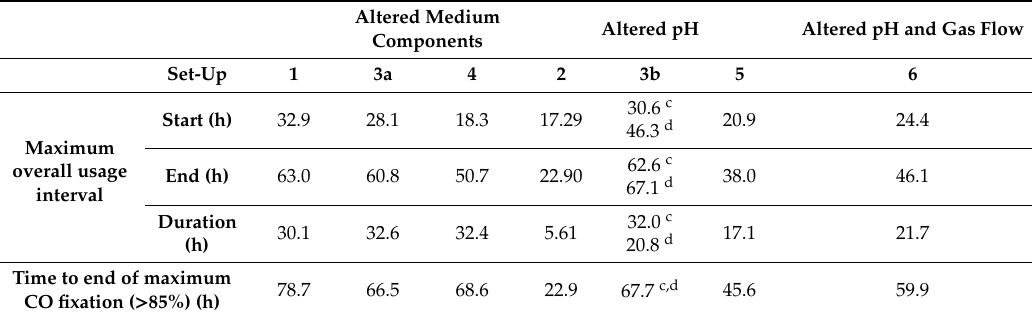
Table 2. Gas consumption profiles. All values given as an average of a triplicate ( n = 3), except for the following: Setup 3a refers to values of the fermenter where pH was not altered and Setup 3b refers to the average of the two fermenters where the pH was changed after 68 h to 5.4, with superscripts c and d designating the value for each individual fermenter, due to the divergence